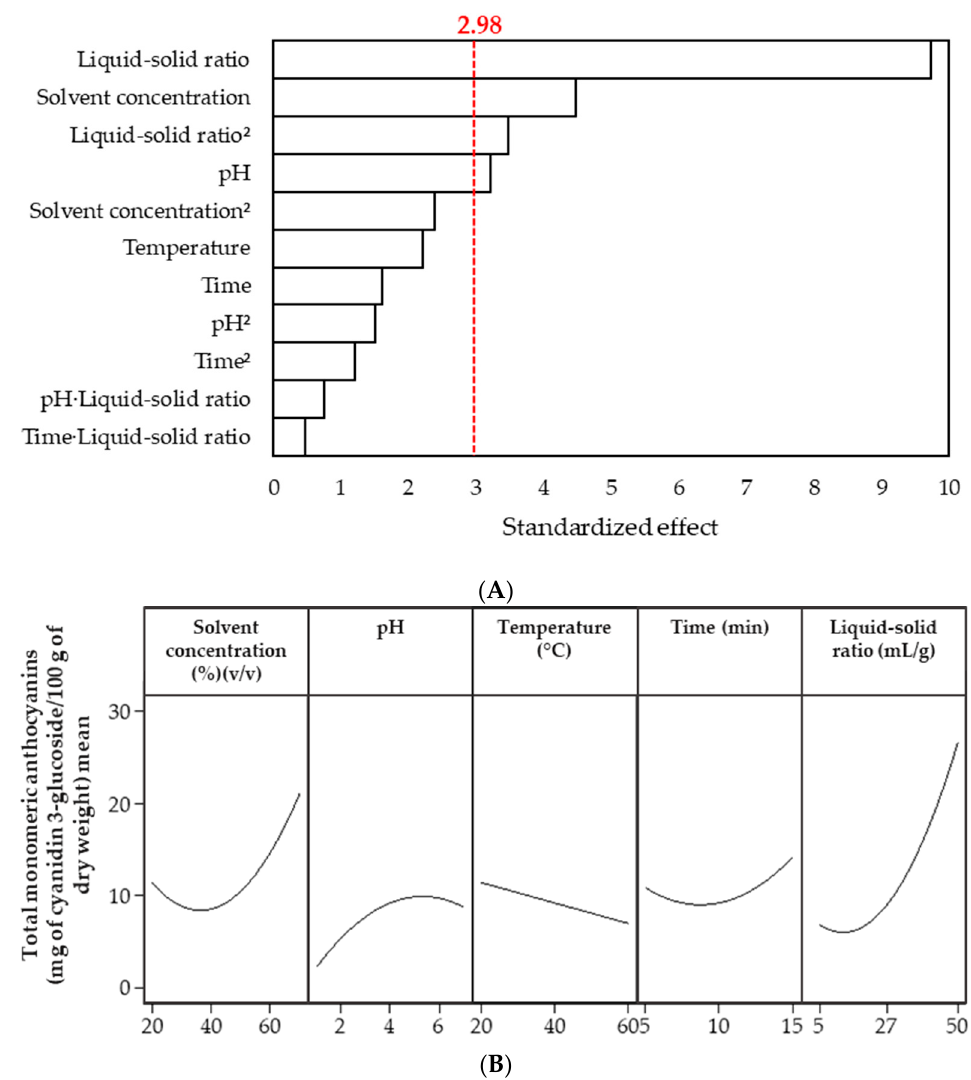
Figure 2. ( A ) Pareto Chart of standardized effects. ( B ) Behavior of the model variables.